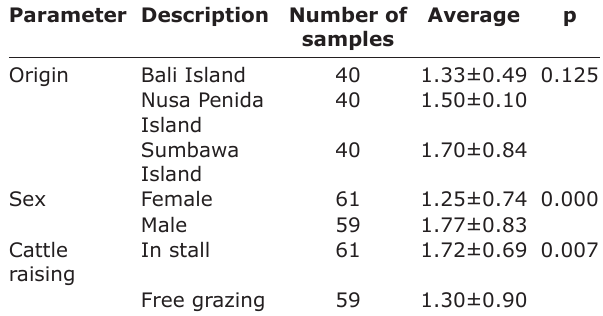
Table-1: Average concentration of bovine growth hormone in the plasma of Bali cattle of different origins, sex, and cattle